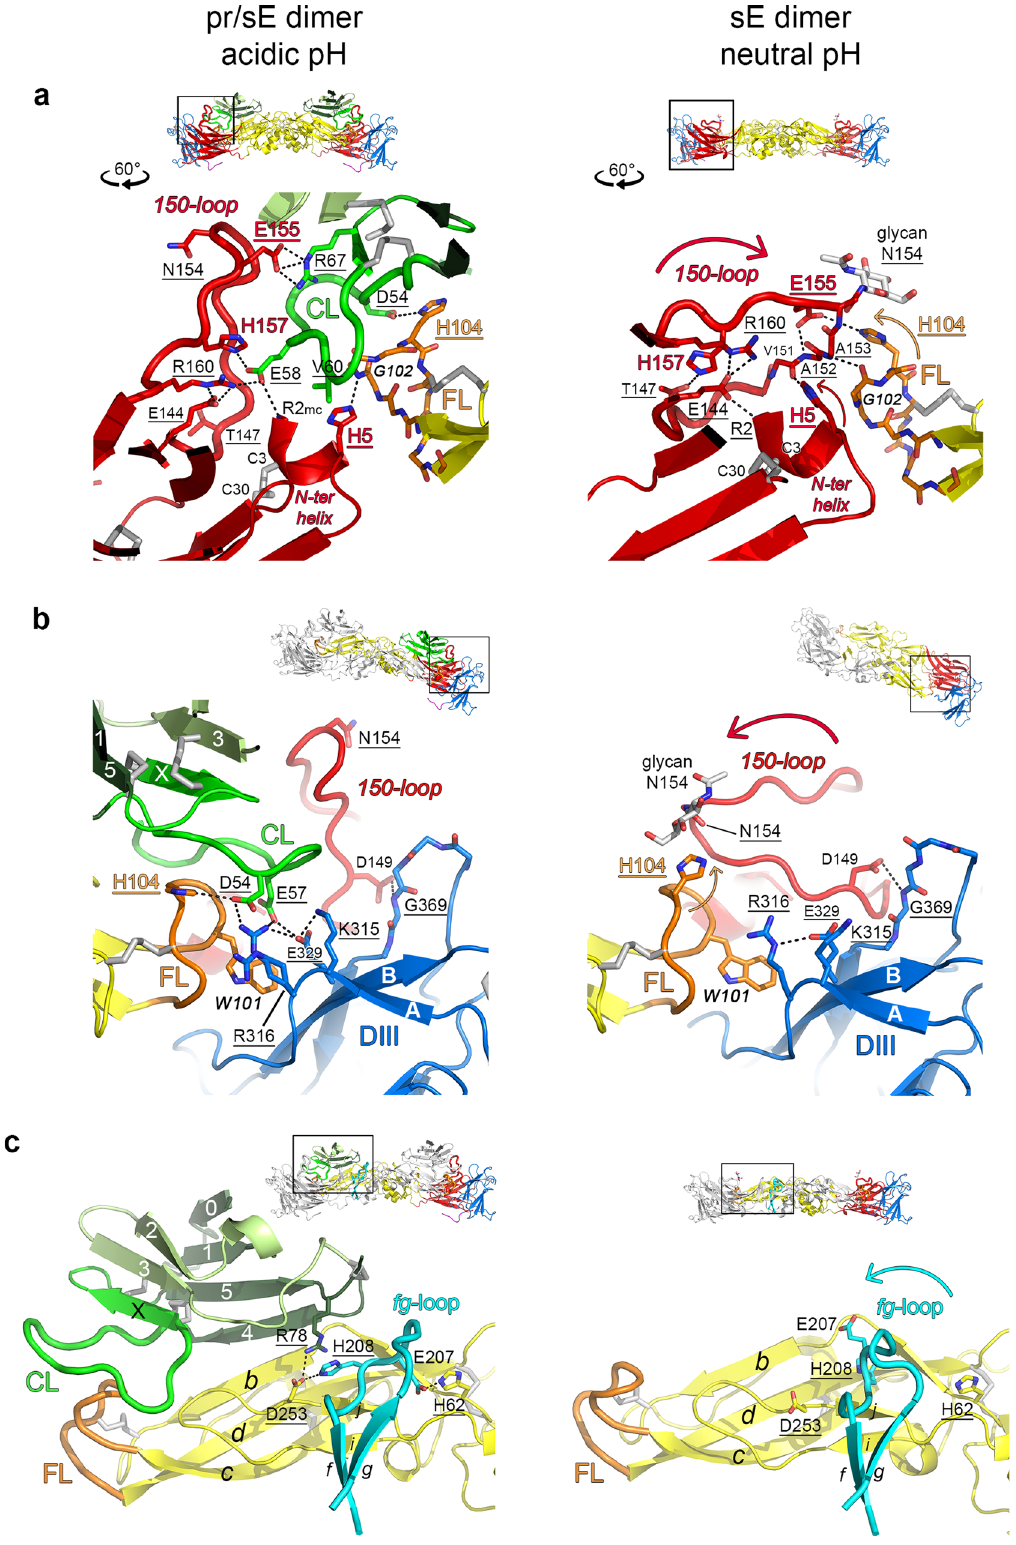
Inspection of the available DENV2 pr/E structure (PDB 3C5X) revealed a disordered 150-loop. This structure was obtained using a single-chain construct connecting the C-terminus of the prM ectodomain (prMe) to the N-terminus of sE via a fl exible linker 30 , thereby eliminating the constitutive positive charge buried at the site corresponding to the E N-terminus. Furthermore, the